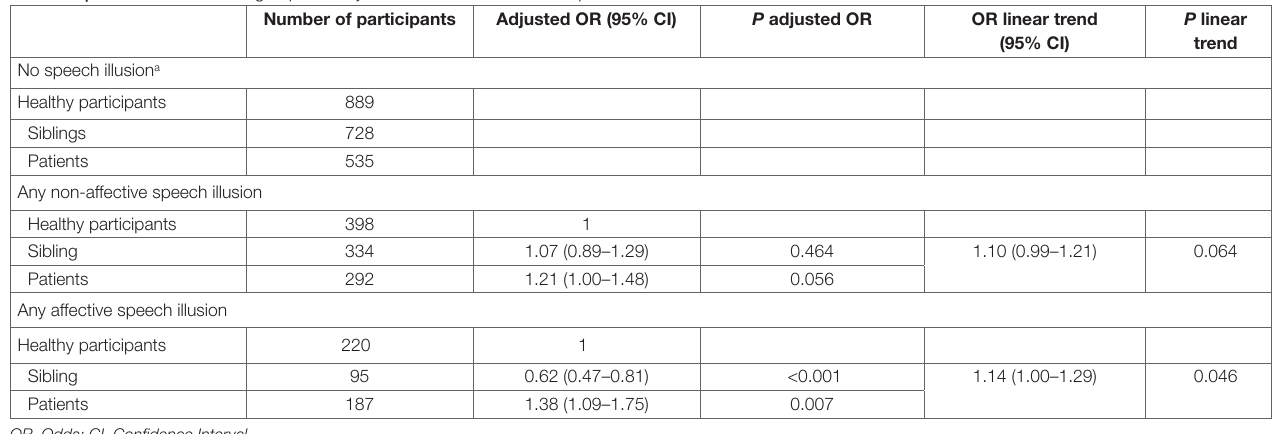
TABLE 3 | Association between group and any non-affective and affective speech